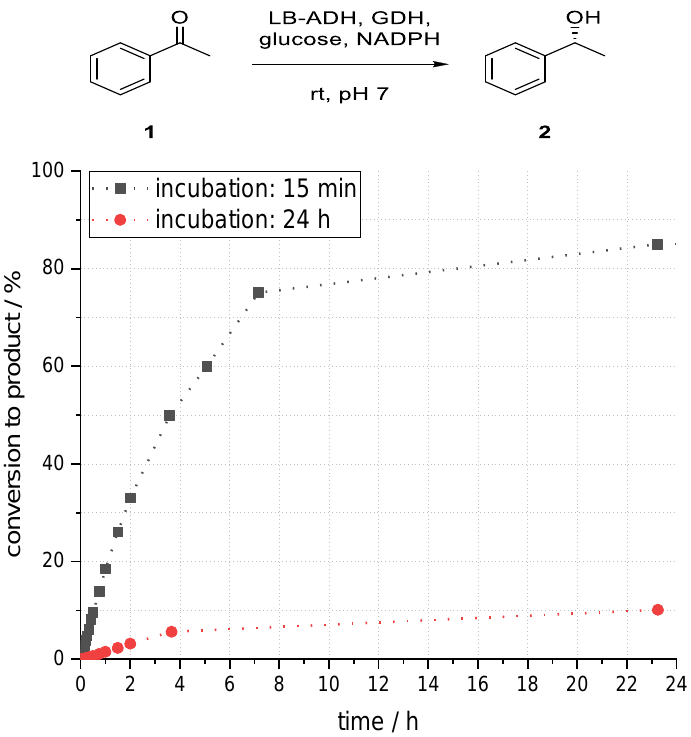
Figure 7. Influence of incubation time on the conversion to phenylethanol ( R )- 2 in an enzymatic reduction of acetophenone ( 1 ) using ADH in superabsorber-immobilized aqueous phase. 3.4. Studies on the Influence of the Ratio of Bu ff er to Solvent on the Acetophenone Reduction with a Superabsorber-Immobilized Recombinant Alcohol Dehydrogenase from Lactobacillus